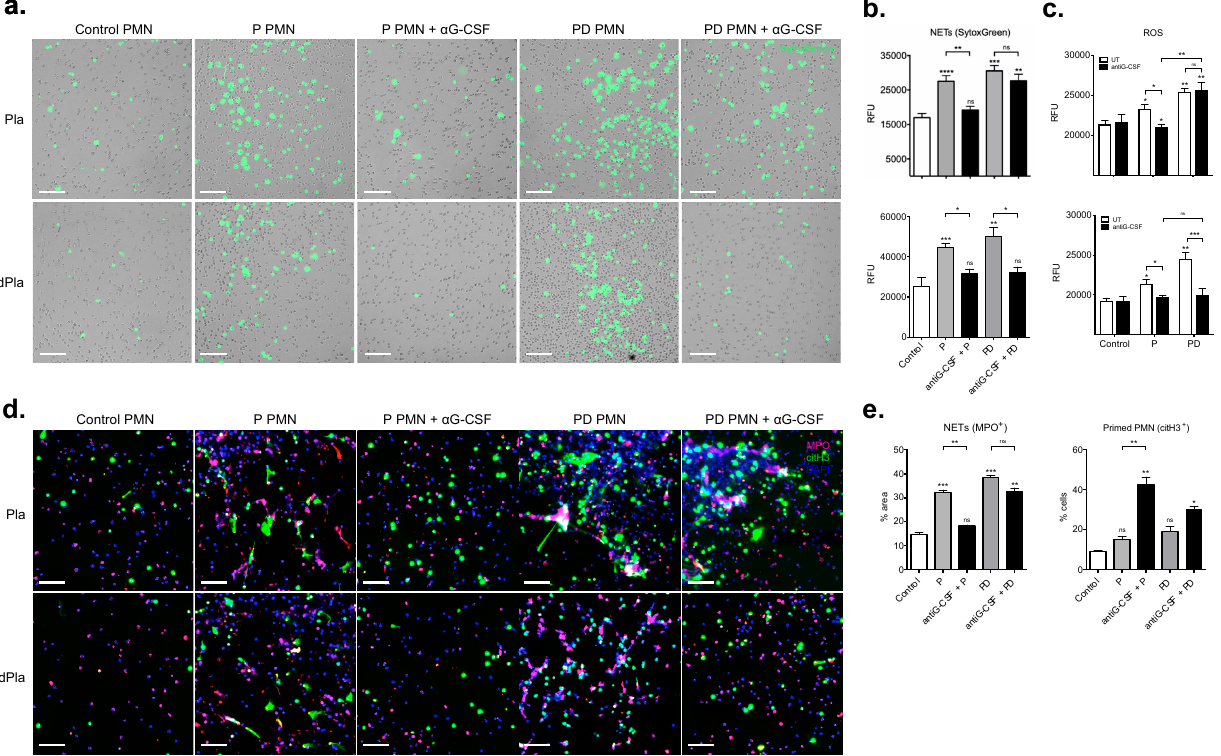
Figure 4. Postpartum NET formation is independent of G-CSF ( a ) NET formation assessed microscopically in a 3 h time course with SytoxGreen DNA binding dye after in vitro incubation of control neutrophils with pregnancy and postpartum plasma (upper panel) and microparticle-depleted plasma with and without antiG-CSF neutralizing antibody pretreatment. Magnification: 10 × . Scale bars: 100 µ m. ( b ) Fluorimetric evaluation of extracellular DNA release and ( c ) measurement of ROS generation by the DCFH-DA plate assay in control neutrophils treated with pregnancy and post-delivery plasma (upper panels) or depleted plasma (lower panels) in the presence of antiG-CSF neutralizing antibody. ( d ) Fluorescent immunostainings for MPO (red), citH3 (green) and DNA (blue) and ( e ) Morphometric analysis of the NETotic (MPO+) and pro-NETotic (citH3+) neutrophils from healthy donors, donors during pregnancy and postpartum. Magnification: 20 × ; Scale bars: 50 µ m. P: pregnancy; PD: post-delivery; aG-CSF: antiG-CSF neutralizing antibody. Data are presented as mean ± sem. * p < 0.05, ** p < 0.01, *** p < 0.001, **** p < 0.0001 (one way ANOVA followed by Bonferroni’s multiple comparison post-test). All experiments were performed at least 6 times with consistent results.